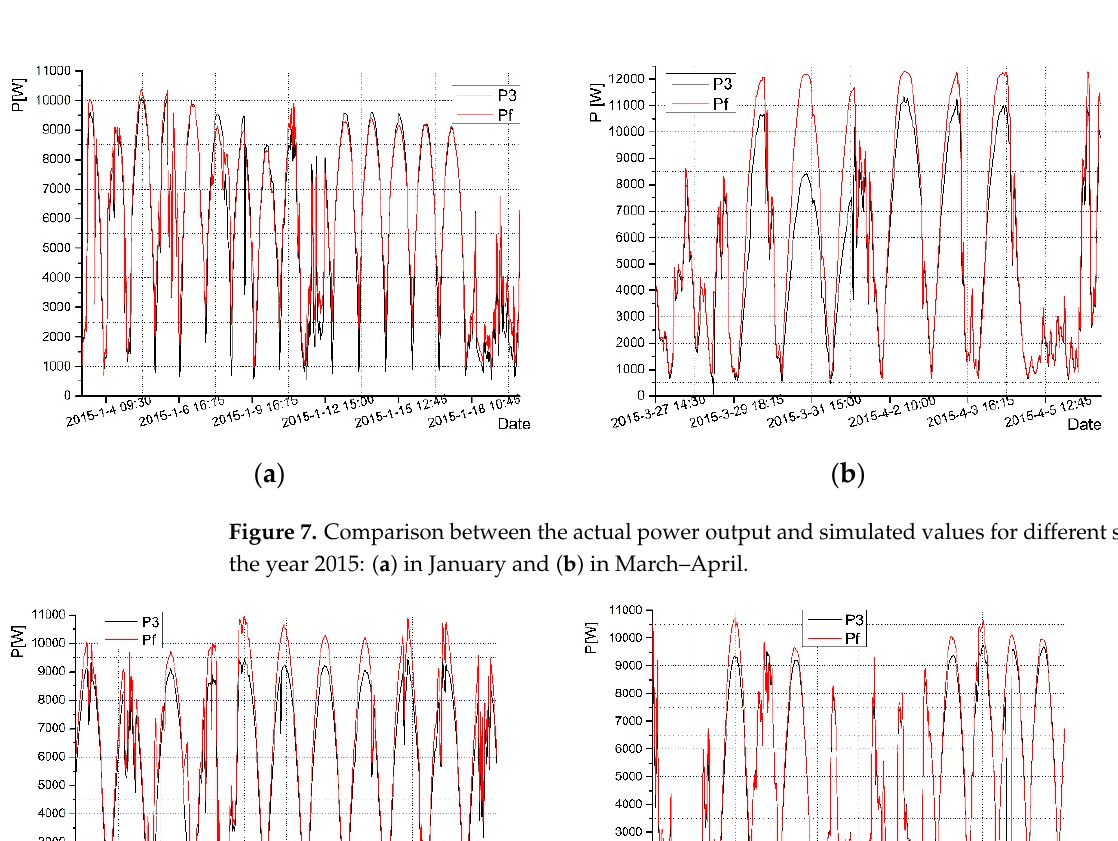
Figure 6. Evolution of NRMSE error during years 2014–2015.